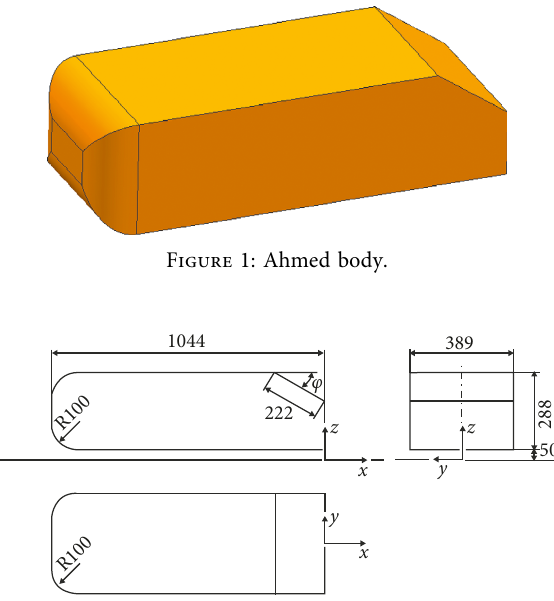
Figure 2: Geometric dimensions of the model (unit: